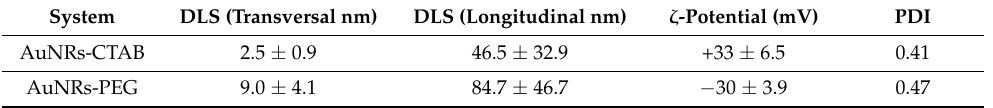
Table 3. DLS, ζ -potential and PDI of AuNRs before and after stabilization with PEG.